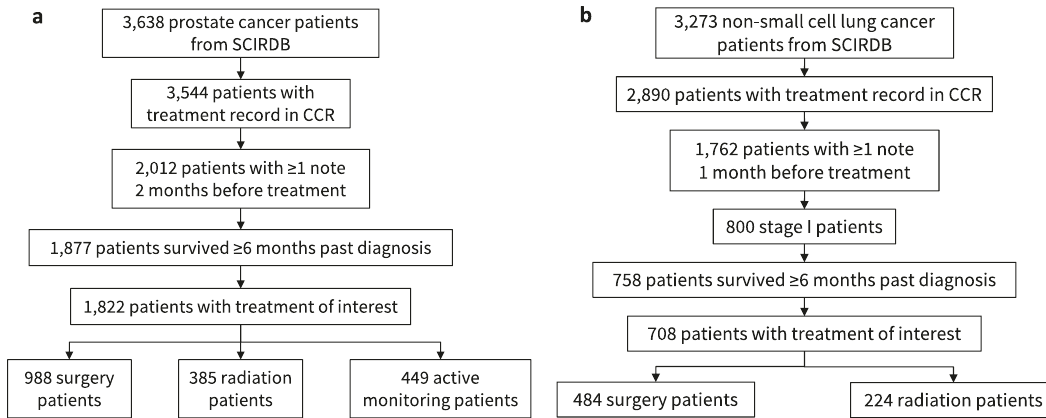
Fig. 4 Patient cohort selection process for prostate and lung cancer patients. a We show the cohort fi ltering process the the subsequent number of patients selected for prostate cancer. b We show the fi ltering process for